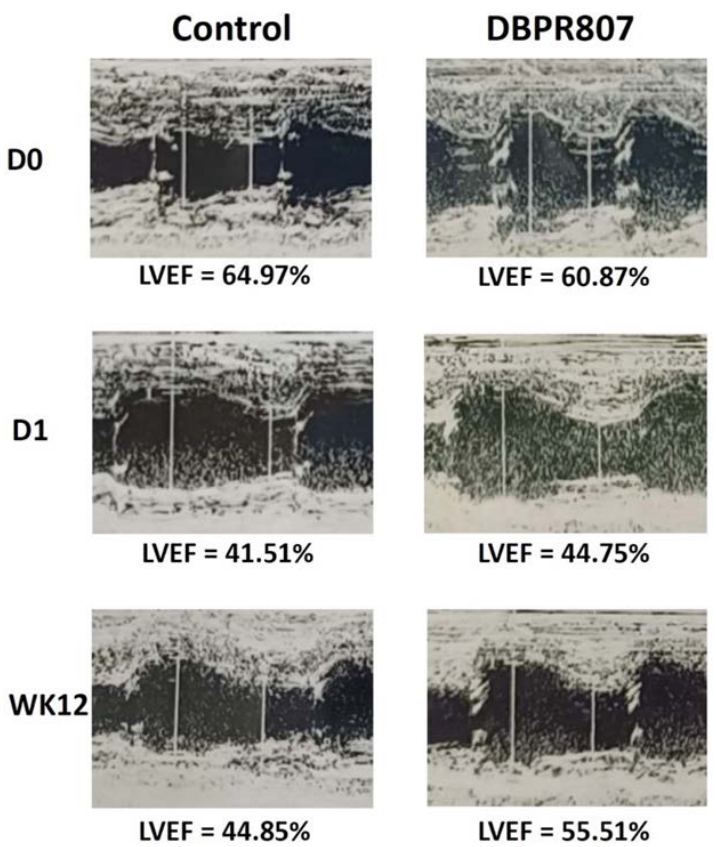
Figure A3. Effects of DBPR807 on the LVEF measured with echo in mini-pigs.